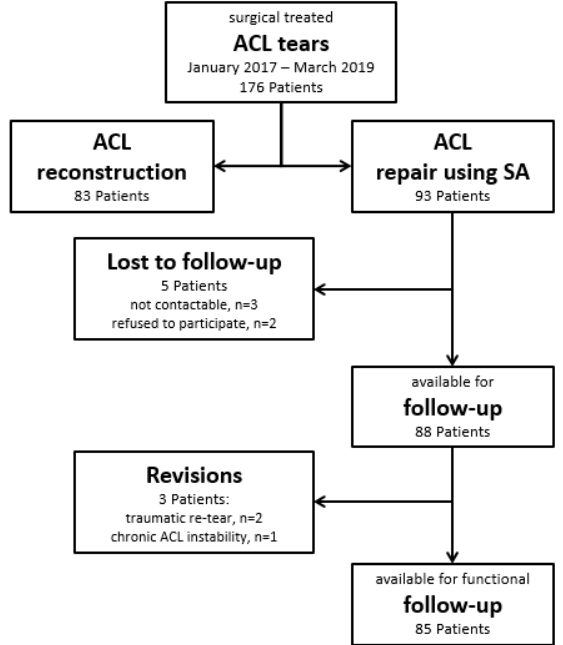
Figure 1. STROBE diagram of surgical treated anterior cruciate ligament (ACL) tears between January 2017 and March 2019.